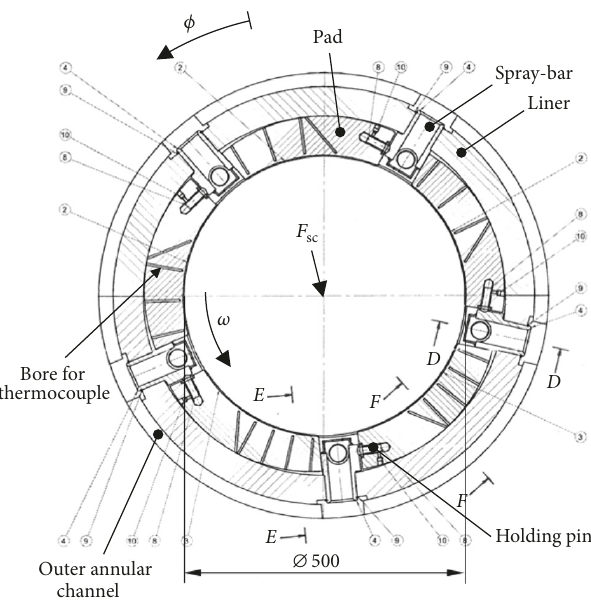
Figure 3: Tilting-pad bearing